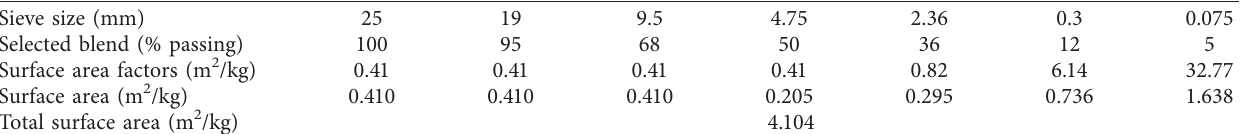
Table 9: Surface area calculation according to AI